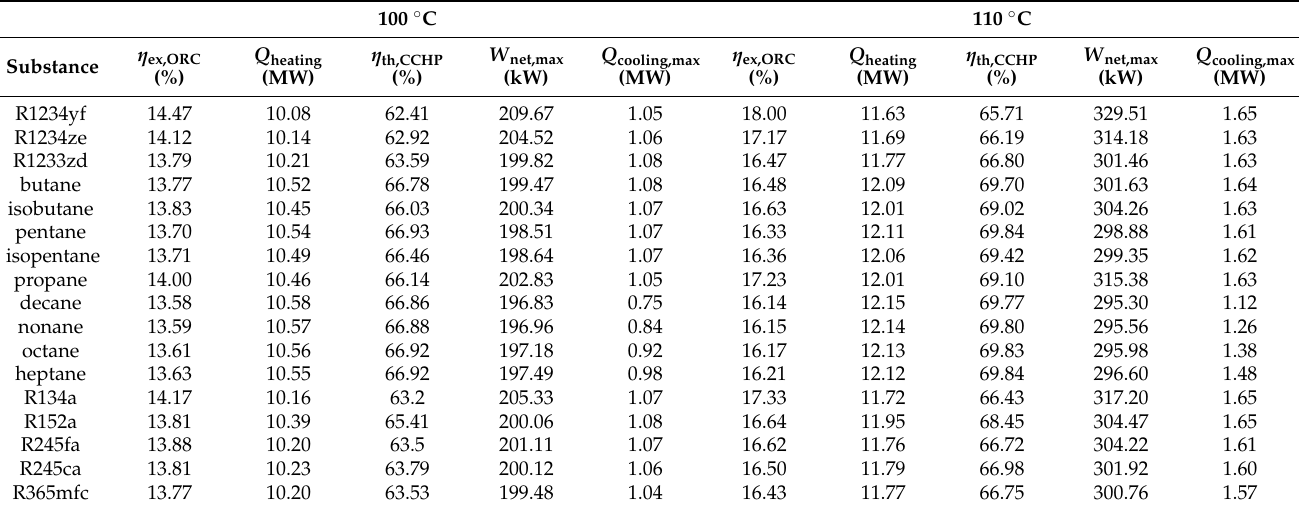
Table 5 indicates the comparative performance of 17 working fluids at the geothermal fluid temperatures of 100 and 110 ◦ C. Within the geothermal fluid temperature range studied, R1234yf and R1234ze in HFOs, propane and isobutane in HCs, R134a and R245fa in HFCs have better power exergy efficiency, respectively. It was apparent that the first four power exergy efficiencies are R1234yf, R1234ze, R134a, and propane. The difference between the maximum and the minimum value are 0.89%, 1.86% in the temperatures 100, 110 ◦ C, separately. It can be concluded that with the increase of geothermal fluid temperature, the gaps of the power exergy efficiency among different working fluids are increasing. Table 5. Performance comparison of working fluids at temperature of geothermal fluid is 100 and 110 ◦